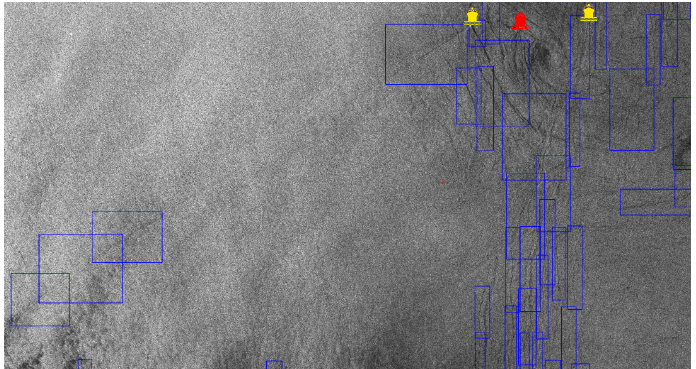
Figure 8. Detections over Scenario A (Azimuth-Ground Range coordinates). Dark vessel in middle indicated in red.